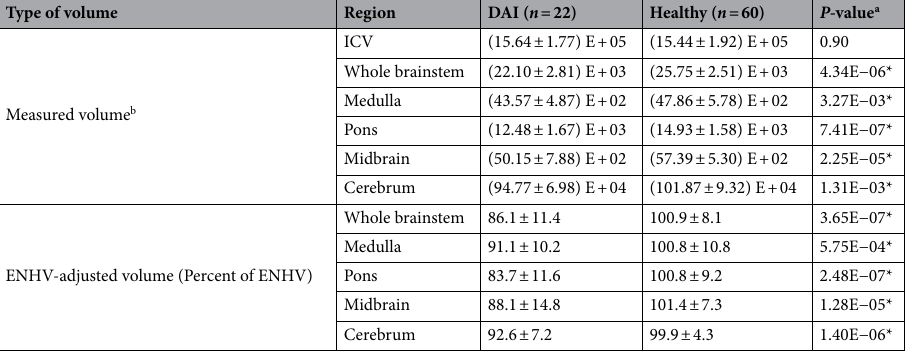
cantly smaller in the whole brainstem (86.1% ± 11.4%) than that in the cerebrum (92.6% ± 7.2%, related-samples Wilcoxon signed-rank test, P = 7.79E−04). The Friedman test showed significant differences in the ENHV- adjusted volume among the three subfields of the brainstem (P = 6.15E−03), and the related-samples Wilcoxon signed-rank test revealed significant differences between the pons and midbrain (P = 1.93E−03) and between the pons and medulla (P = 1.38E−03), even after Bonferroni correction for multiple comparisons. However, there was no significant difference between the midbrain and medulla (P = 1.40E−01). In DAI patients, the pons had a significantly greater ratio of volume loss than that in the midbrain or medulla. We confirmed that the mean ENHV-adjusted volume in HCs was reasonably close to 100 (98.5–101.5) for all ROIs.